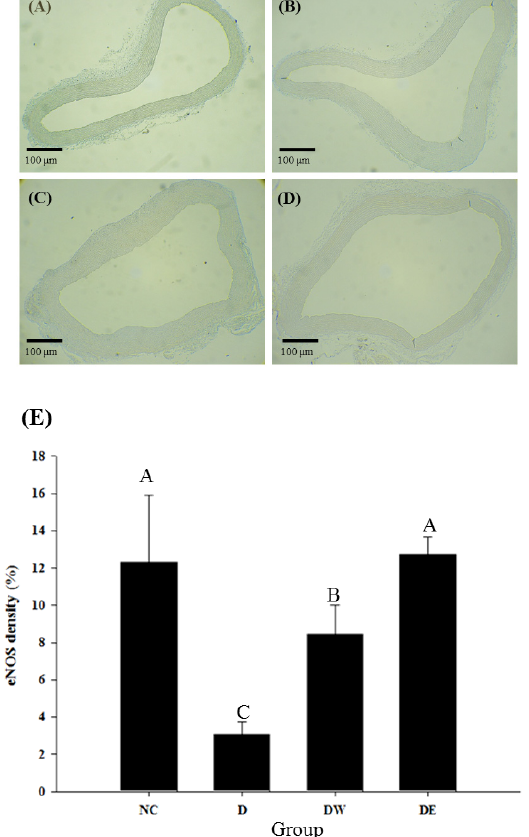
Figure 5. Effects of administration of the extracts of TWK10 ‐ fermented soymilk on of eNOS in the sections of aorta in DOCA-salt induced hypertension and its associated dementia rats immunohistochemical of eNOS in the sections of aorta in DOCA ‐ salt induced hypertension and its associated dementia rats NC ( A ), D ( B ), DW ( C ), DE ( D ), and eNOS density ( E ). (100 NC ( A ); D ( B ); DW ( C ); DE ( D ); and eNOS density ( E ). (100 magnification); Data are presented as magnification); Data are presented as means ± SD ( n = 6); Bar values with different uppercase means ˘ SD ( n = 6); Bar values with different uppercase letters were significantly different by Duncan’s letters were significantly different by Duncan’s multiple range test ( p < 0.05); NC: normal multiple range test ( p < 0.05); NC: normal control group; D: DOCA-salt at a dose of 20 mg/kg bw; DW: DOCA-salt with administration of water extract of TWK10-fermented soymilk at a dose of 2.65 g/kg bw; DE: DOCA-salt with administration of ethanol extract of TWK10-fermented soymilk at a dose of 0.09 g/kg